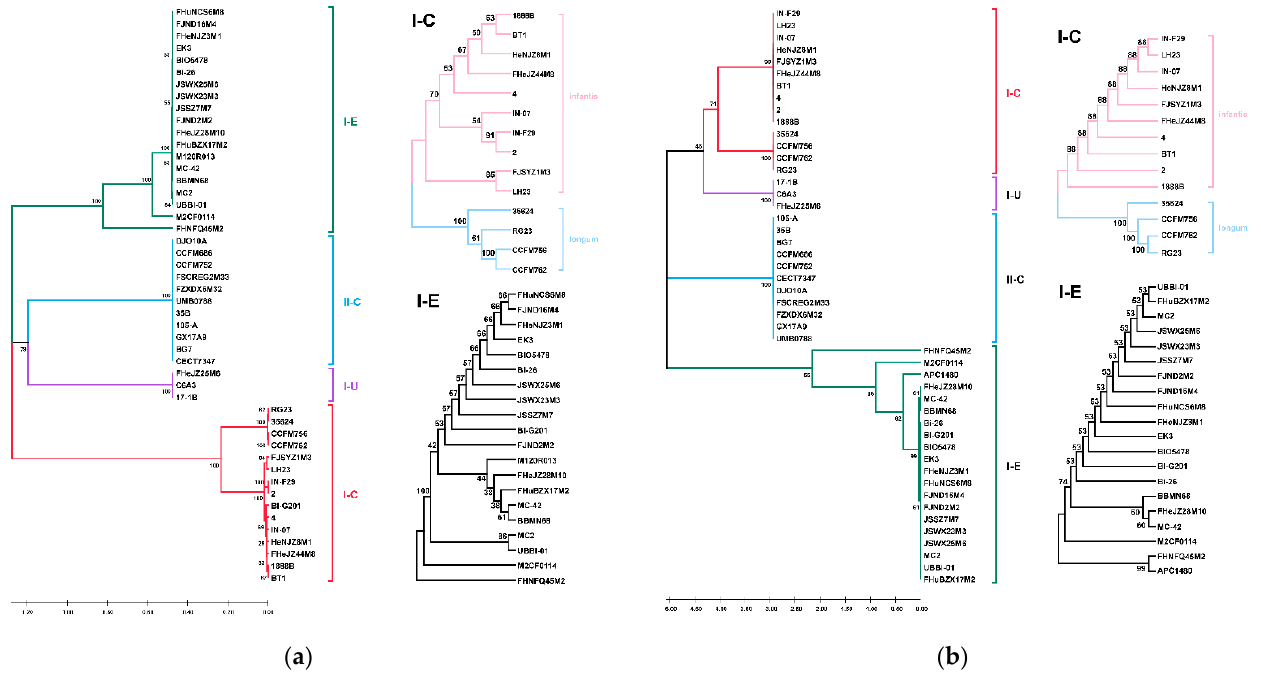
Figure 8. Phylogenetic tree based on Cas1 proteins ( a ) and repeat sequences ( b ). CRISPR-Cas subtypes or subspecies are shown on the right, and each group was marked with colour. The tree was drawn with UPGMA using 1000 bootstrap replicates. Bootstrap values were recorded on the nodes.